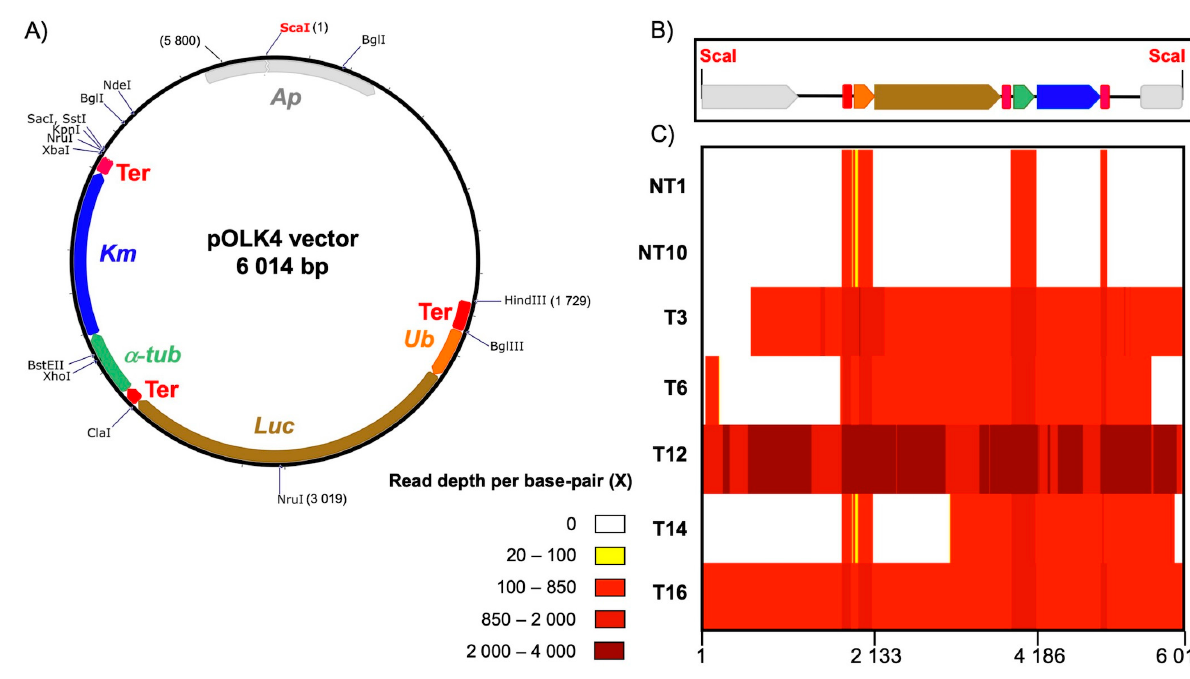
Figure 1. Sequence map and read coverage of the pOLK4 vector. ( A ) Map of the circular pOLK4 vector. Gray arrow: Ap, ampicillin-resistance gene; blue arrow: Km, kanamycin (G418) antibiotic-resistance gene used as a selectable marker for algal transformation; brown arrow: Luc, luciferase used as a luminescence reporter gene; orange arrow: ubiquitin promoter; green arrow: α -tubulin promoter; and red block: Ter, α -tubulin terminator. Positions of restriction sites are shown. ( B ) Map of the linear pOLK4 vector that the algal cells were transformed with highlighting of the Sca-I restriction site (red) used to linearize vector DNA. Colors of the gene maps are as in ( A ). ( C ) Heatmap of short reads from untransformed (NTx) and transformed (Tx) lines mapped against the linearized vector, showing no read coverage (white) to high read coverage (dark red).